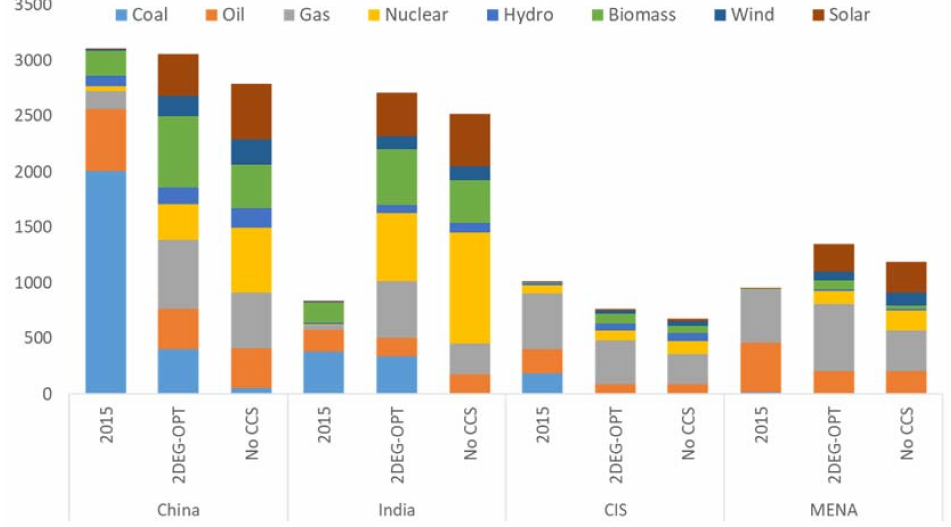
Figure 7. Primary energy consumption by fuel in developing economies in 2050 (in